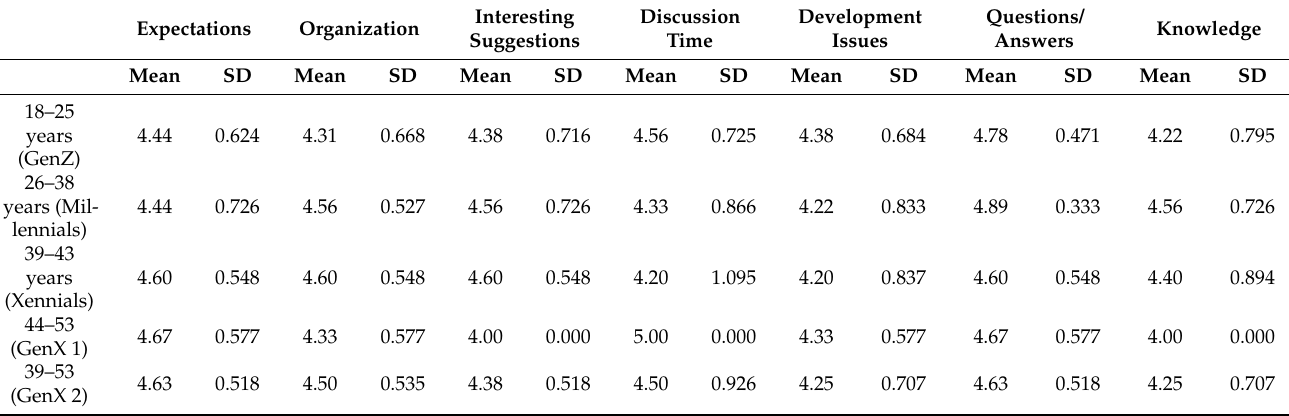
Table 5. Mean values and standard deviations of “acquired knowledge organization” questions in relation to age groups (generational cohorts) of budding